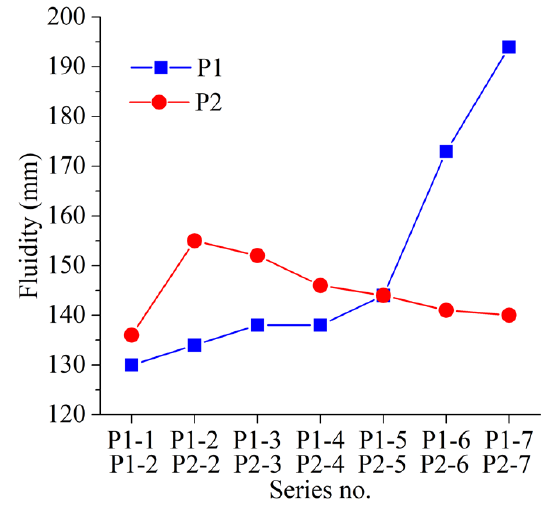
Figure 7. Fluidity of pastes.